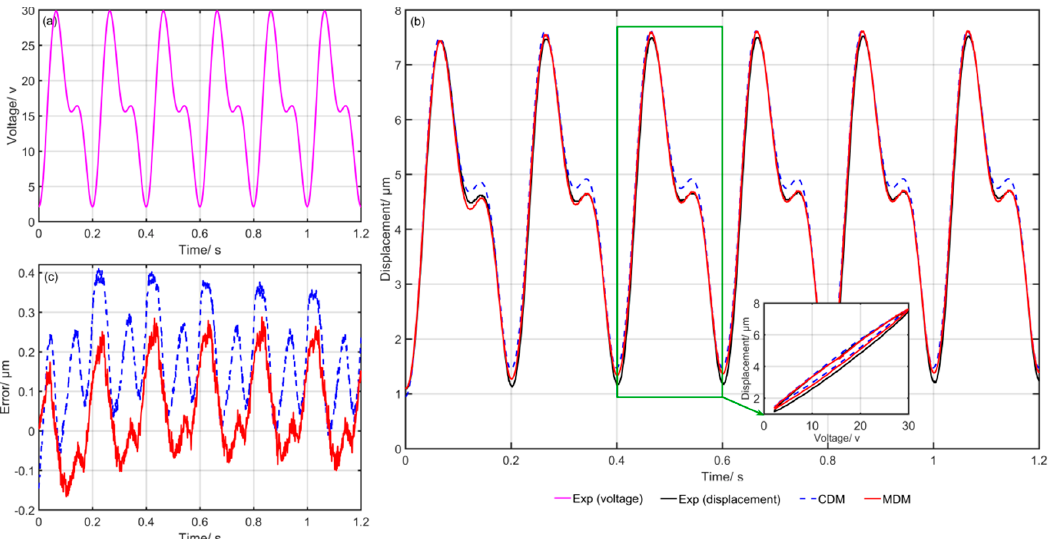
Figure 8. Exp3: Comparison of the experimental and simulation results of the CDM and MDM under u 3 ( t ) = 10sin ( 2 π · 5 t ) + 6sin ( 2 π · 10 t ) + 16: ( a ) Time histories of input voltage, ( b ) time histories of output displacements and ( c ) time histories of errors of the CDM and MDM.